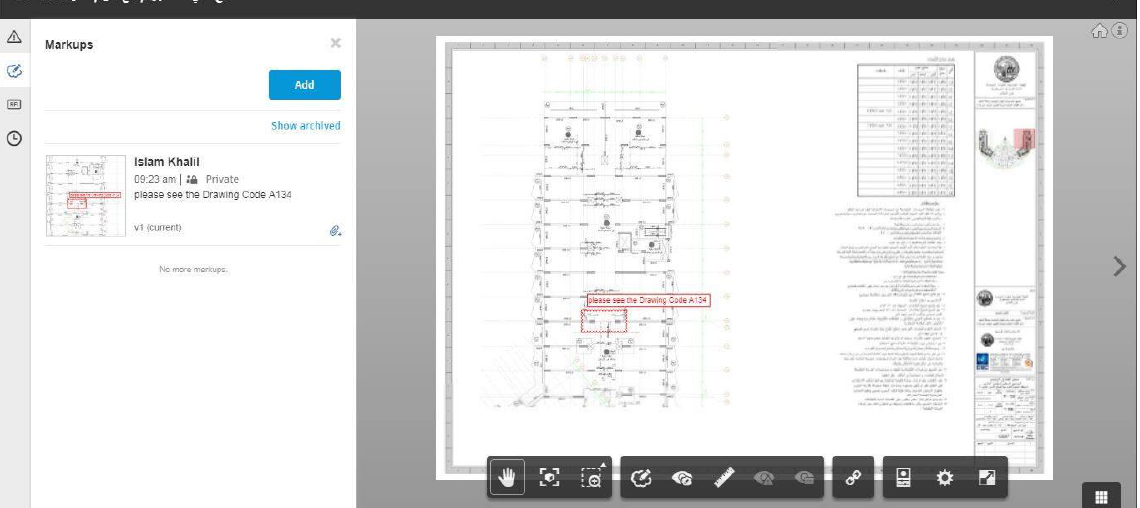
Figure 3: BIM 360 Doc (issues – The military Hotel/ALAMEIN).